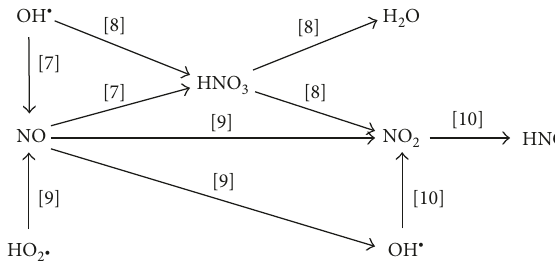
Figure 2: Photocatalytic oxidation of NO over TiO